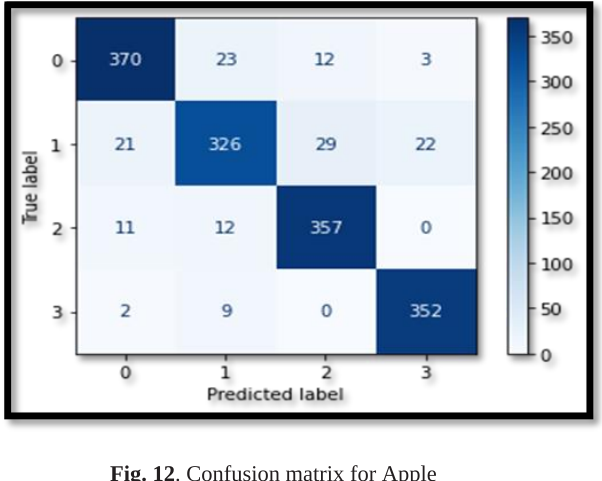
Fig. 12 . Confusion matrix for Apple dataset